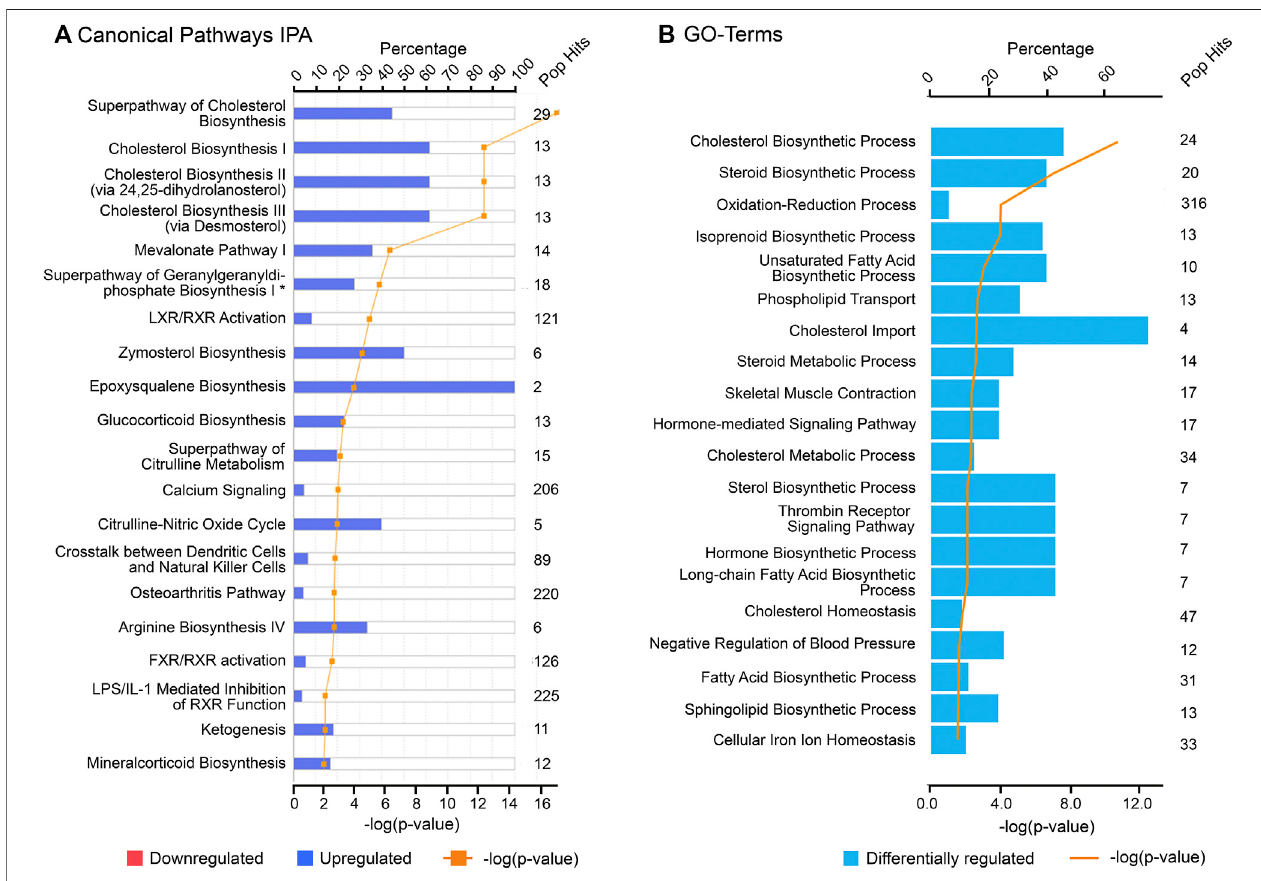
FIGURE 5 | Top canonical pathways associated with cluster 4 ( “ late ” genes) using (A) Ingenuity Pathway Analysis (IPA) and (B) Gene Ontology (GO), biological processes from DAVID database. “ Pop Hits ” refers to the total number of genes associated with each of the pathway in the database. The bar graphs represent the percentageofgenesfromthedatasetthatmaptoeachcanonicalpathwaywhilsttheorangelineshowsthe p -valueofoverlapbetweengenesineachclusterandagiven pathway.